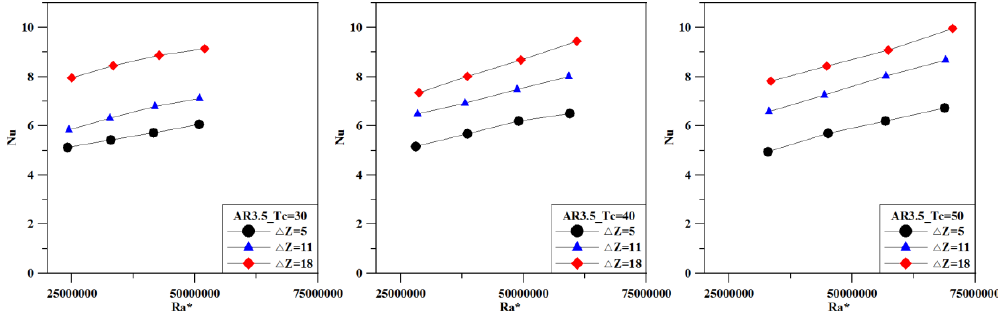
Figure 5. The relationship between the Nusselt number of loop flow and the modified Rayleigh